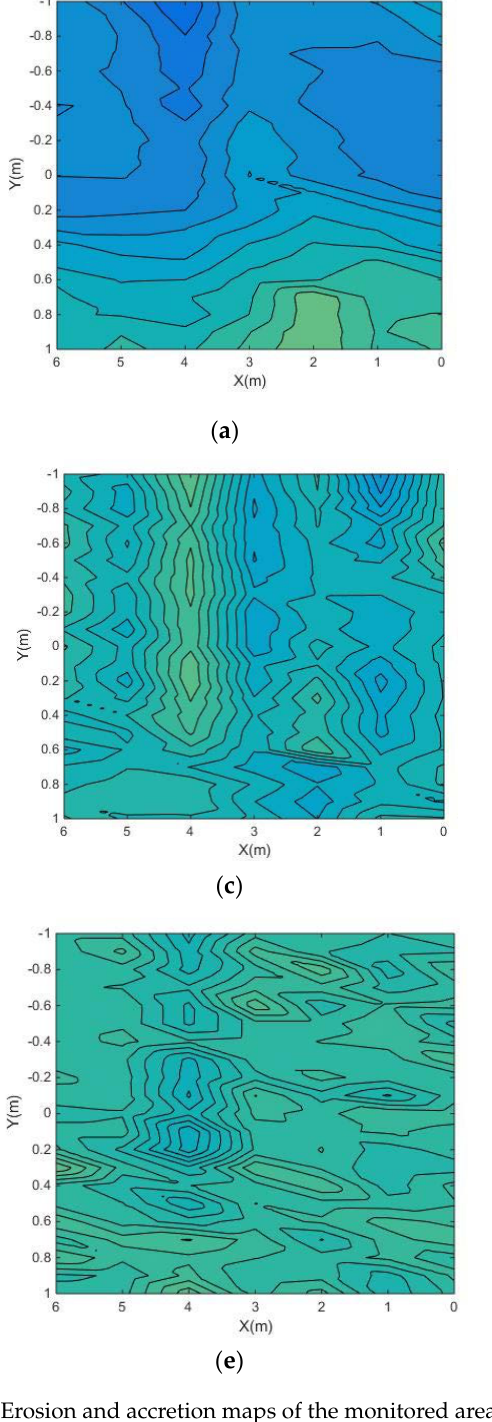
Figure 9 represents the position of the bathymetric contour lines of the P4 profile, z = 0.4 m and z = 0 .3 m over time. The contour for z = 0 .4 m corresponds to the shoreline and mean water lever (MWL); the z = 0 .3 m contour is represented, since the profiler was not able to monitor the complete movement of the shoreline throughout the laboratory tests. Due to the lack of available data concerning the shoreline position, it is assumed that the shoreline presents a similar behavior to the evolution of the z = 0 .3 m contour. Thus, the retreat of the z = 0 .3 m contour line was used to estimate the average retreat rates for each profile. At some instants, profile P4 intercepted the z = 0 .3 m contour twice (from t = 1 020 min till the end of scenario A.1), which indicates the presence of a bar. Different colors represent different contour lines, while the dashed lines represent a second profile inter- ception at the same level. All the lines show a general retreat of the cross-shore profile.